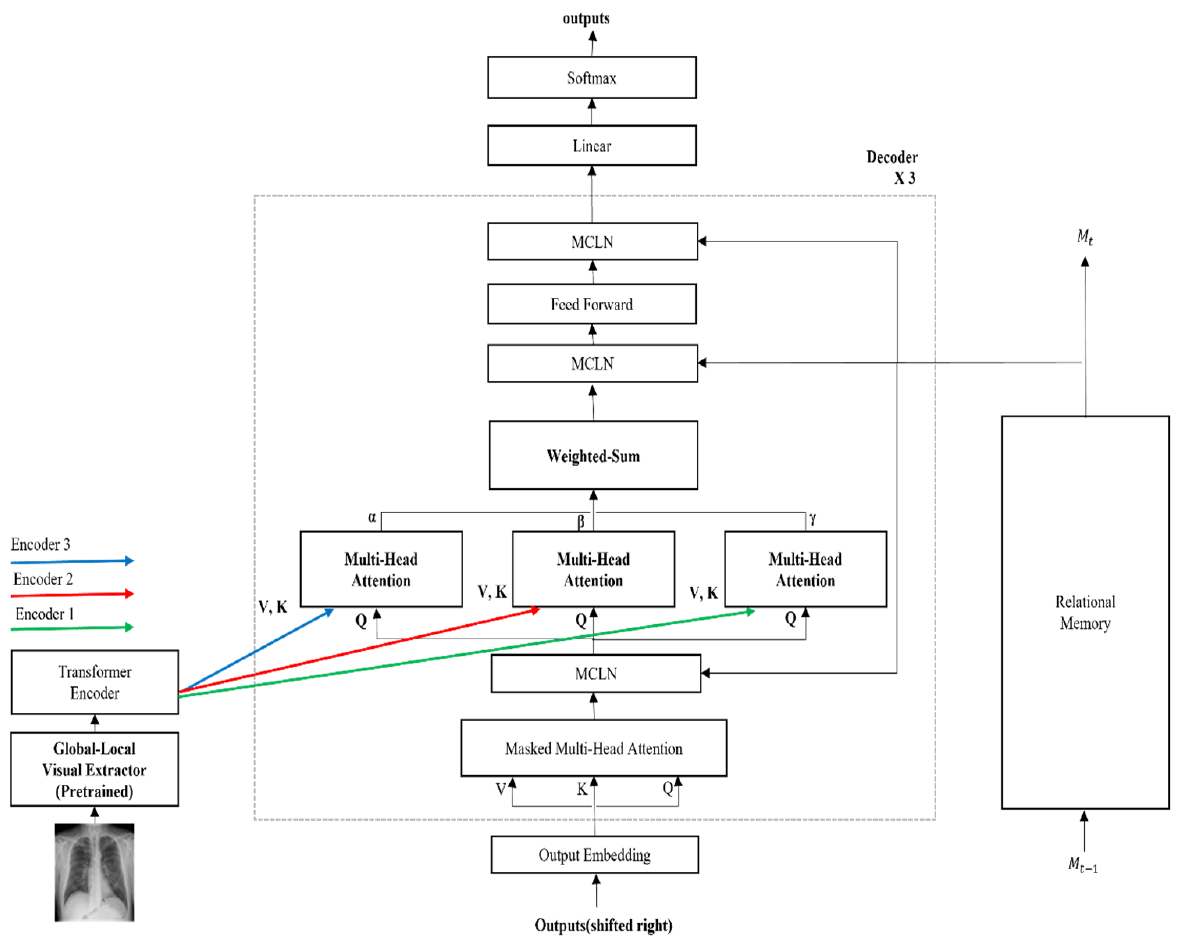
Figure 5. The overall architecture of our proposed model which combines both GLVE and CEDT. The gray dash box shows the detailed structure of our proposed decoder.